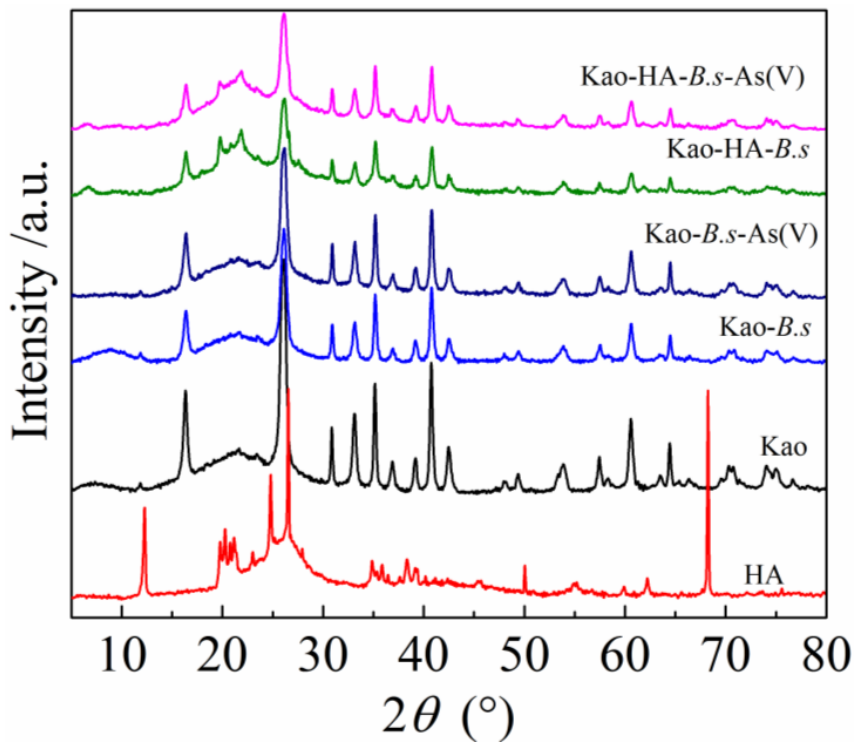
Figure 9. XRD pattern of composites before and after As(V) adsorption. The peaks at 16.37 ◦ and 25.98 ◦ are assignable to the typical characteristic diffraction pattern of kaolinite, corresponding to (001) and (002) of kaolinite (JCPDS No. 01-080-0886), respectively. There was no significant change in the basal spacing of the kaolinite after the adsorption of HA or bacteria, indicating that they were not intercalated into the interlayer of the kaolinite due to the large molecule structure, which was also reported by Wu and Chassapis et al. [52,53]. In contrast, interlayer spacing increased from 0.5411 nm to 0.55 nm for the Kao- B.subtilis Kao-HA- B.subtilis complexes upon the reaction with As(V), revealing that the inner-sphere complex for the Kao- B.subtilis and Kao-HA- B.subtilis composites. The increase in this interlayer spacing in the Kao- B.subtilis system suggested that As(V) could penetrate the bacteria in the outer layer banded with carboxyl groups and form various inner-sphere complexes with kaolinite due to the variable charges in the latter gibbsite basal planes [54,55] or the arsenic ions that were initially adsorbed on bacterial and/or humic acid surfaces (at lower HA content), which were bound to the lower potential of humic acid [56]. As the reaction proceeded, they would gradually transfer to the high potential energy mineral functional groups through chemical bonds or co-ordinate covalent bonds, thus forming an internal layer complex.